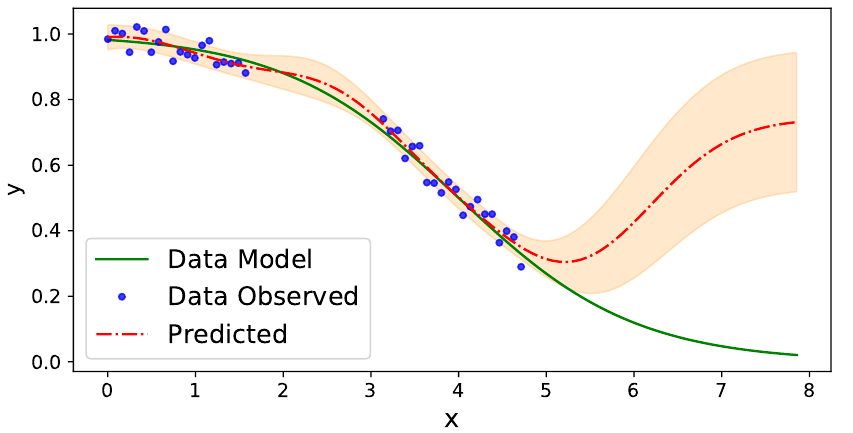
Figure 3. Gaussian Process Regression (red dashed line depicts the predictive mean and orange fill depicts the standard deviation intervals) with noisy measurements (blue dots) of the sigmoid function (solid green line) using Gaussian kernel and constant mean